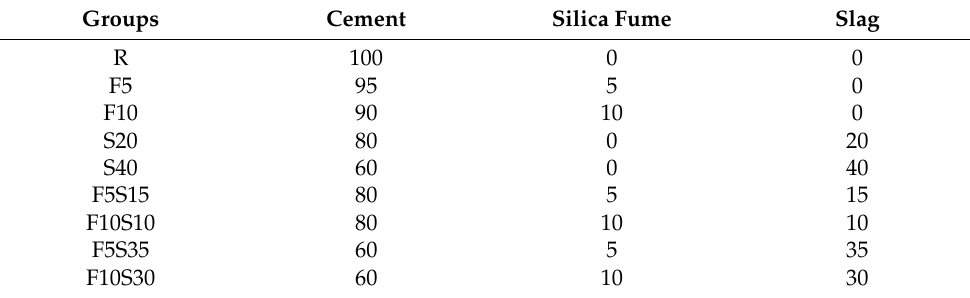
6 of 15 Figure 3. Particle size distribution of cement, slag and SF. 3.2. Mix Proportions The mix proportions of the cementitious materials are presented in Table 2. Nine